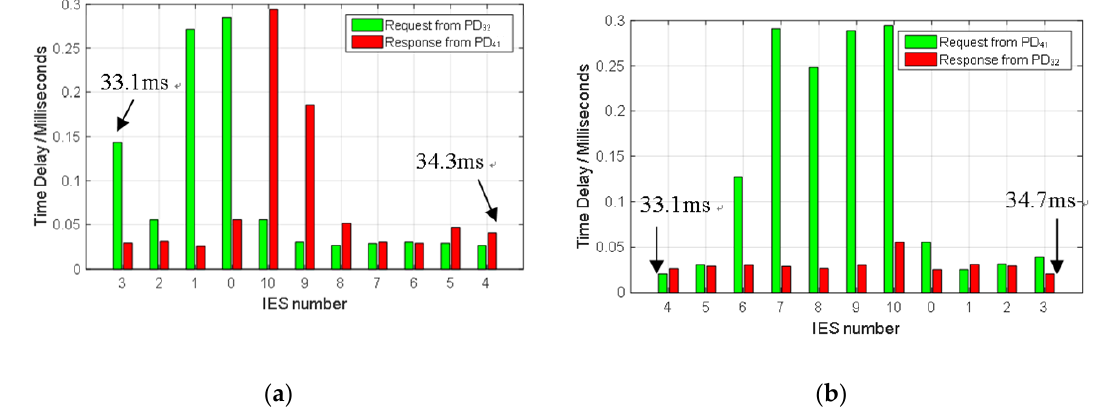
Figure 11. The time delay of each IES when PD 32 ( a ) and PD 41 ( b ) communicate.